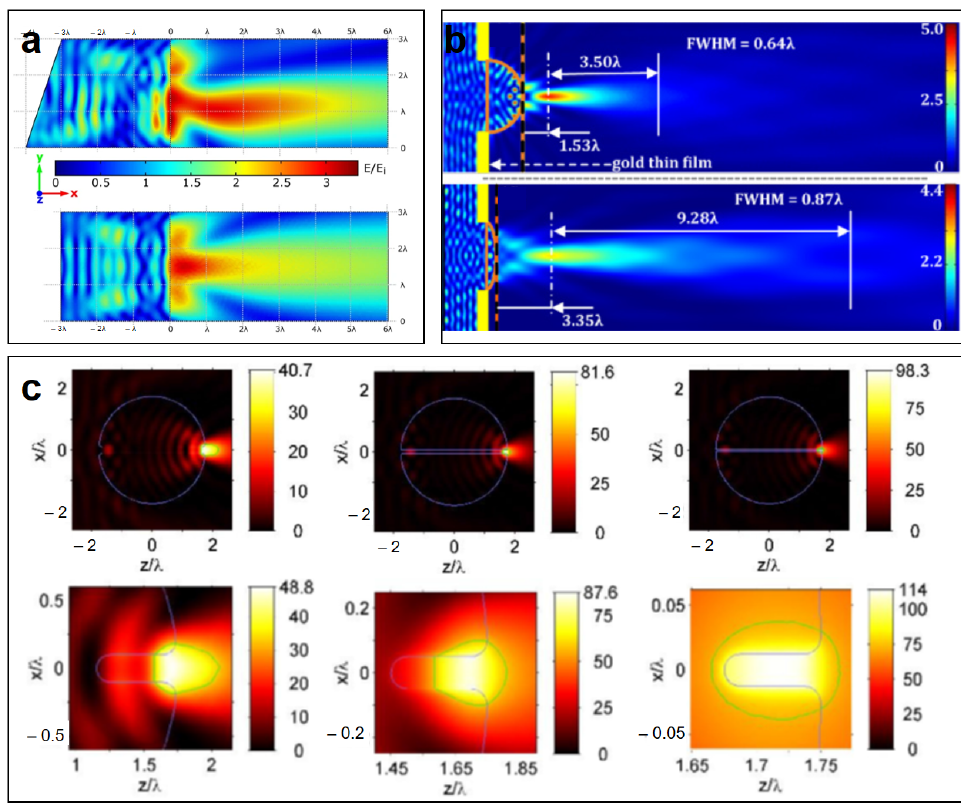
Figure 3. Generation of photonic nanojet of microlens with different structures. ( a ) Intensity of light field generated by asymmetric cuboids and cubes; ( b ) Spatial intensity distribution of structures with radius of curvature of 2 λ and 4 λ ; ( c ) Light intensity of the simulated dielectric microspheres with a nanohole of size λ /5, λ /10, λ /15 and dielectric microspheres with a blind nanohole of the diameter λ /5, λ /10, λ /40.